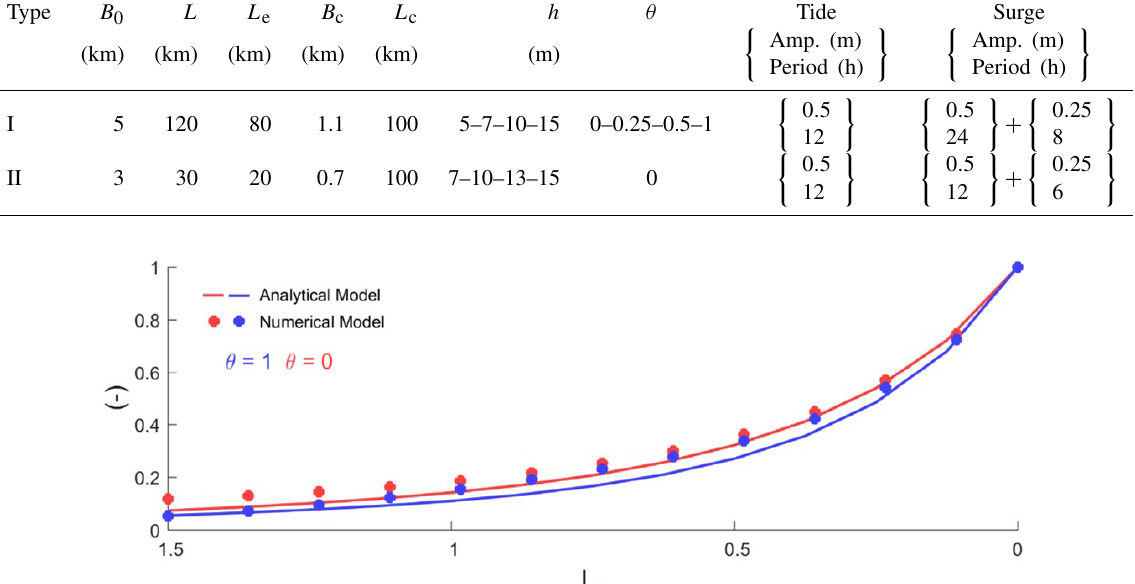
Table 1. Analytical model parameters used in this study. See Appendix A for a description of the parameters. Nondimensional river discharge ( θ ) is applied at the upstream boundary, and tide and surge waves are applied at the ocean boundary (i.e., the estuary mouth, which is x = 0 in Fig. 1).